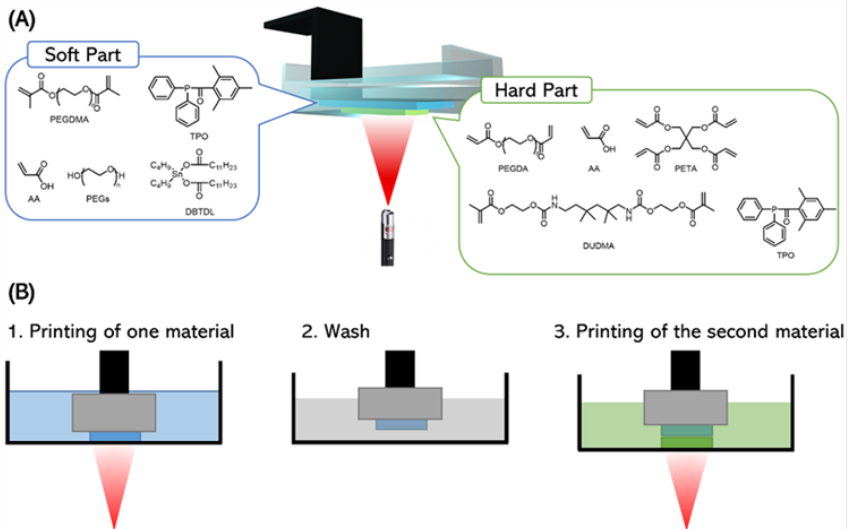
Figure 1. Concept of the multi-material printing system. ( A ) The resin composition for the soft (blue) and rigid material (green). ( B ) Schematic illustrations of the process flow for multi-material printing using three steps: printing with the first material, washing with solvent to remove the residue resin, and printing with the next material.